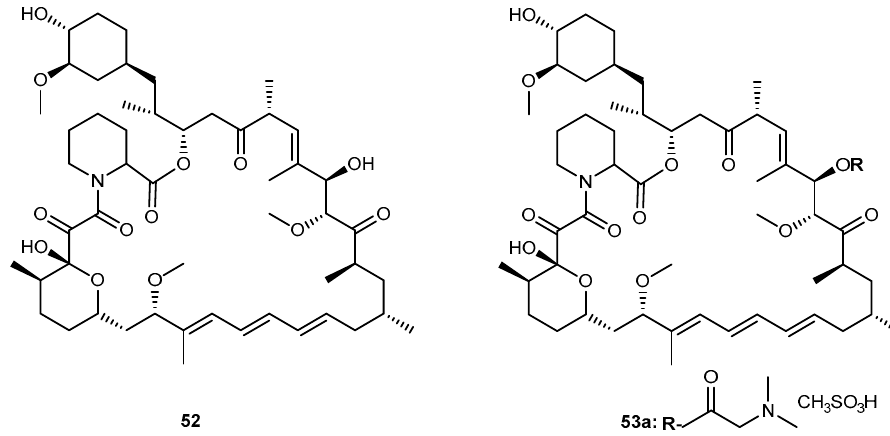
Figure 24. Structure of rapamycin ( 52 ) and its glycinate derivative ( 53a ).